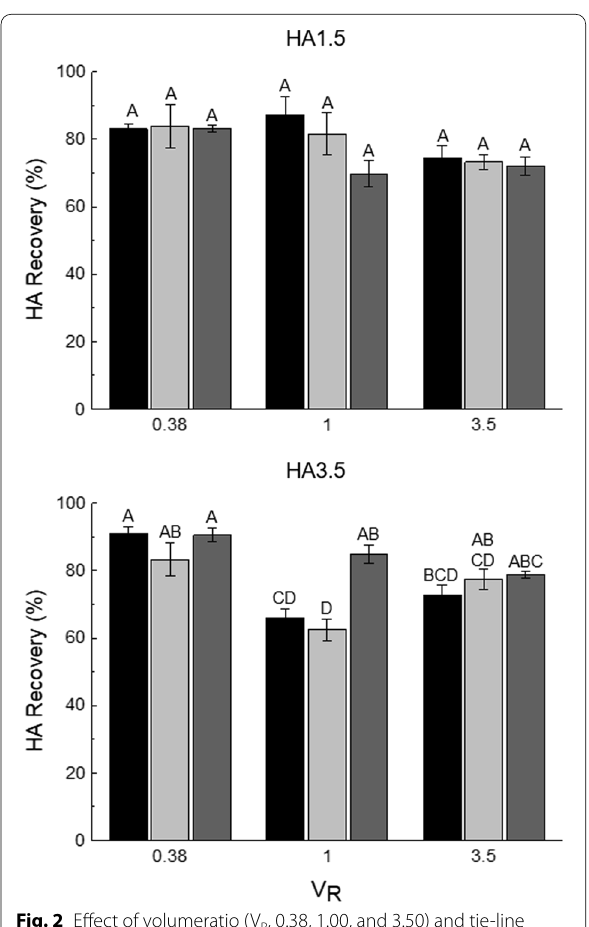
Fig. 2 Effect of volumeratio (V R , 0.38, 1.00, and 3.50) and tie‑line length (TLL, 24 ( ),36 ( ), and 43 ( ) % w/w) on hyaluronic acid (HA) recovery in the bottomphase of polyethylene glycol (PEG) 8000–citrate aqueous two‑phase systems (ATPS).Two pure HA solutions of different molecular weights: 1–2 MDa (HA1.5) and 3–4 MDa (HA3.5) were evaluated. HA solutions were loaded to the ATPS at a finalconcentration of 10% (w/w). Bars represent the sample mean SEMof experimental triplicates. Bars within the same graph ± that do not share thesame uppercase letter aresignificantly different (p < 0.05)